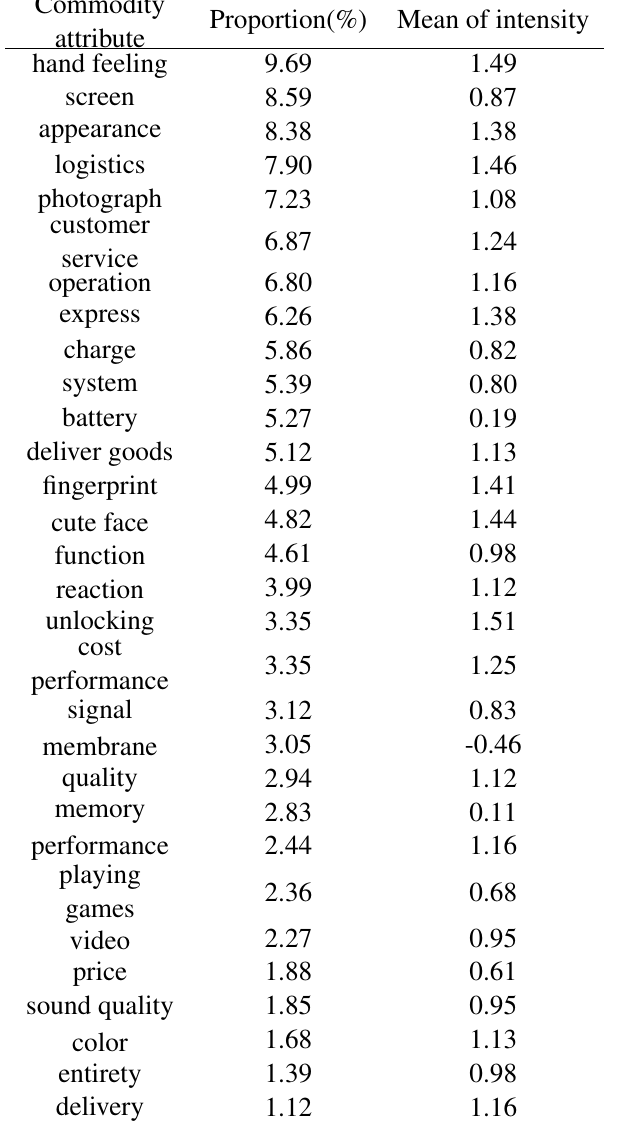
Table 3 The proportion and mean value of sentimental polarity intensity of attributes